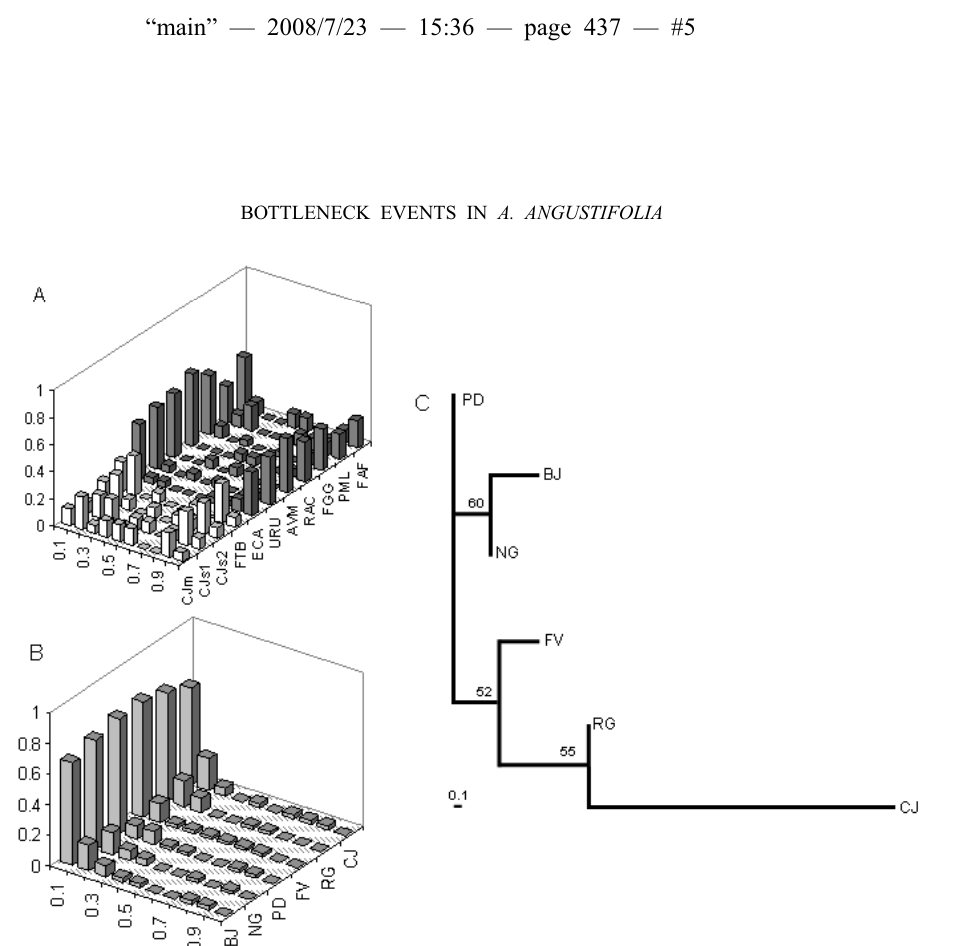
Fig. 2 – Molecular signatures of bottleneck events in A. angustifolia populations. ( A ) Plotting of the frequency distribution of allele classes for isozymes. Populations CJm, CJs1, CJs2 and FTB revealed a shifted distribution, indicating historical reduction of the effective population size. ( B ) Plotting of the frequency distribution of allele classes for microsatellites. All populations revealed a non-shifted alleles distribution, meaning absence of bottleneck signatures. ( C ) Neighbour-joining phylogram computed for microsatellite data based on (δμ) 2 genetic distance. Evidence of a bottleneck event in population CJ is given by the elongated branch length. Numbers at nodes in the phylogram are bootstrap values after 1000